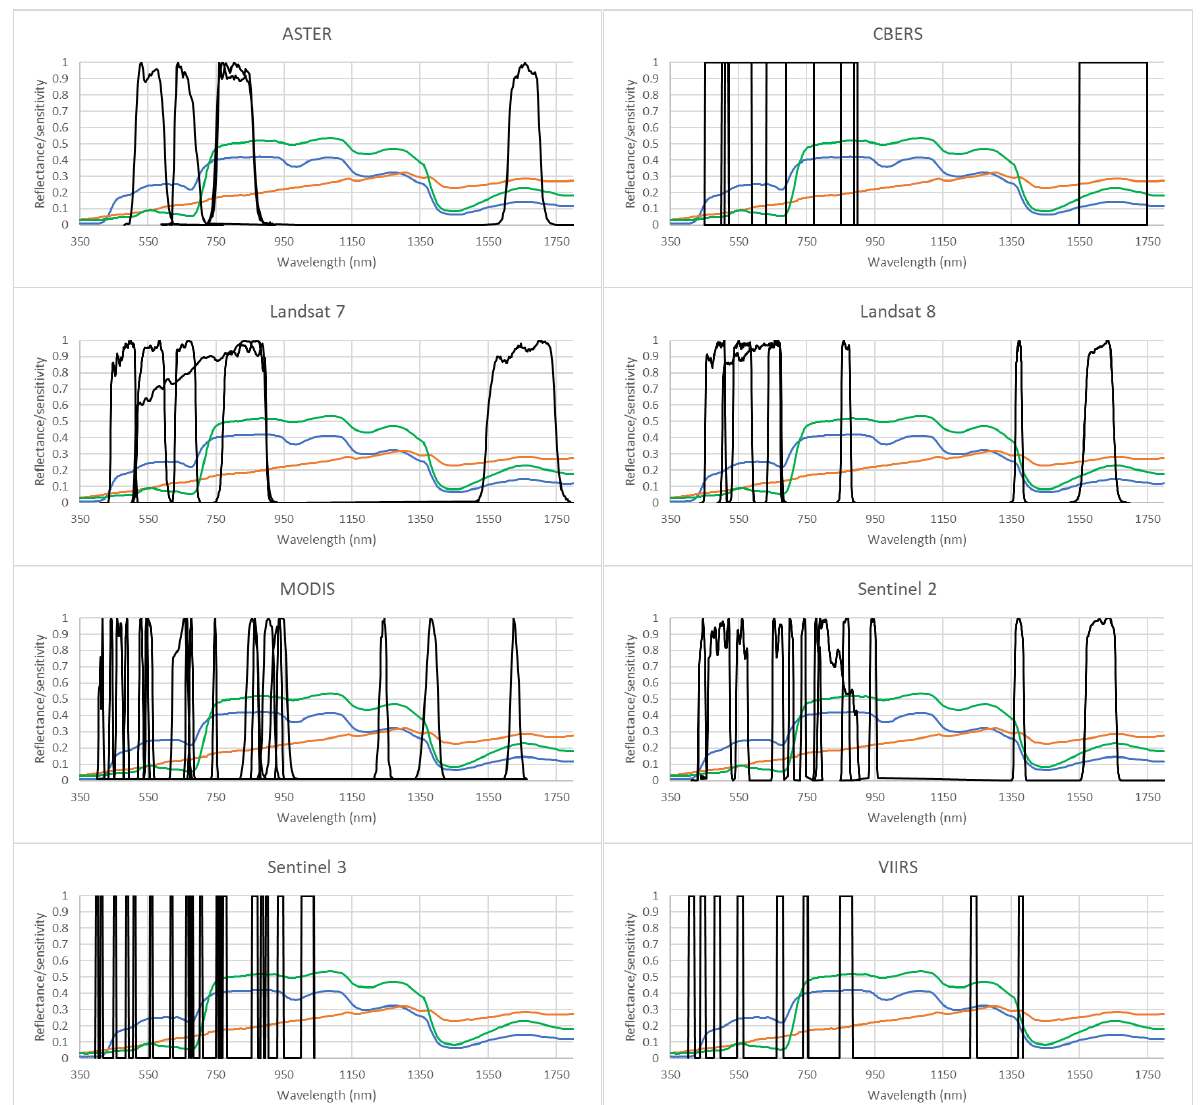
Figure 6. Spectral bands for satellite sensors overlain on median reflectance spectra from ASD spectroradiometer